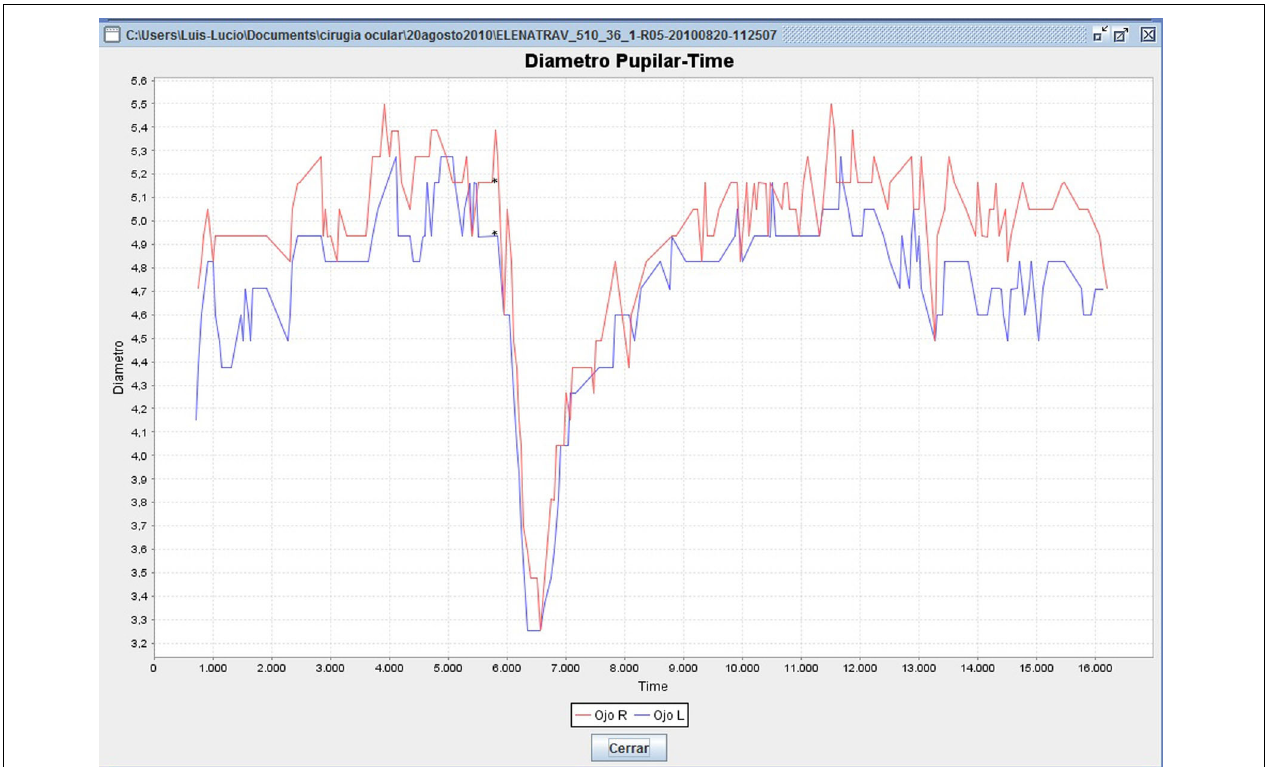
FIGURE 1 | Pupillometry menu generated by Cabanillas software (data from a 36-year-old woman). The upper curve (red) shows OS pupil reaction; lower curve (blue) shows OD pupil reaction. Asterisks on